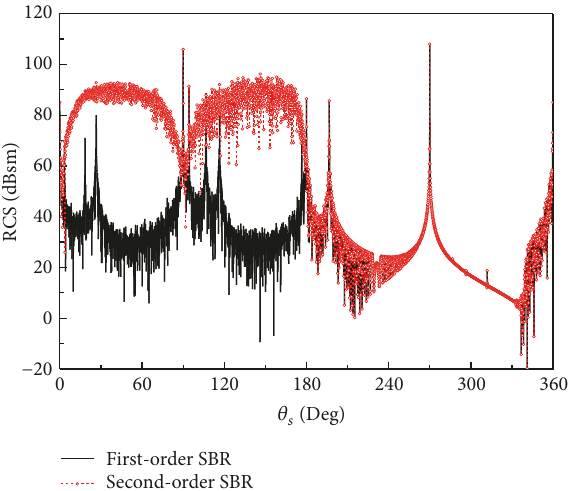
Figure 7: Monostatic RCS results for the ship with the incident plane at 10GHz.